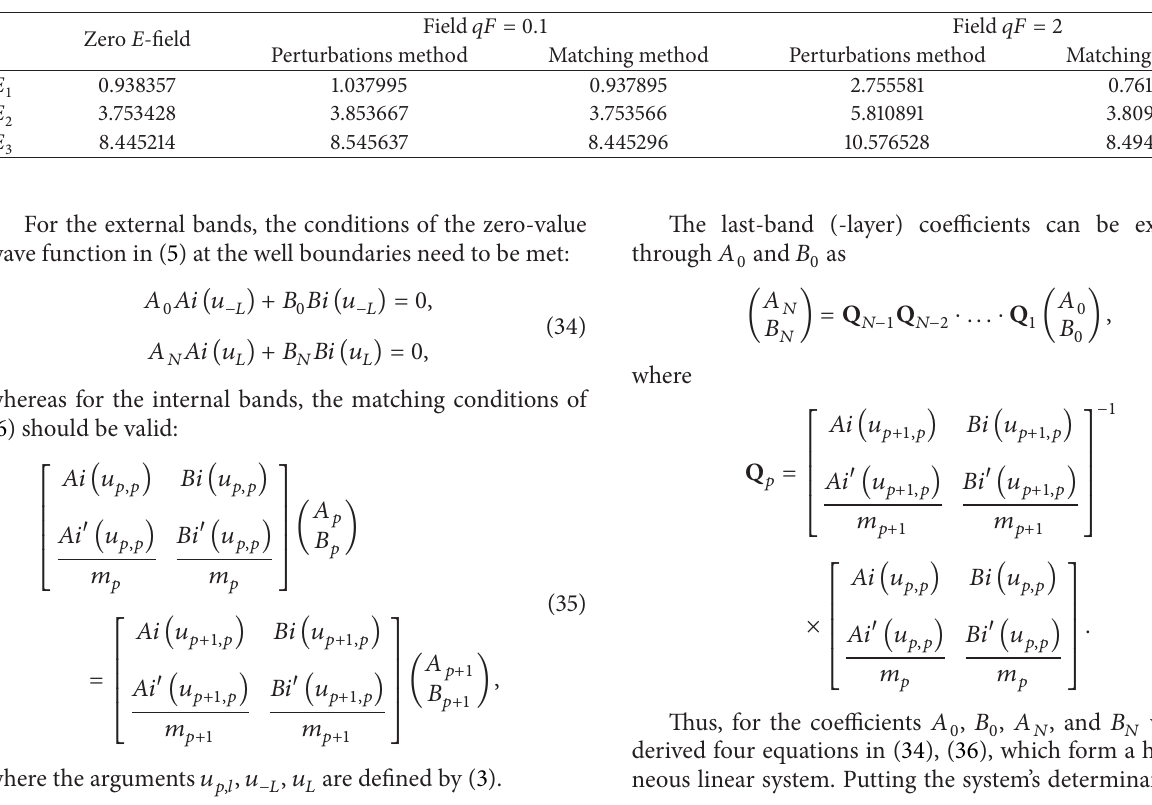
Figure 3: Wave functions for the infinite well (zero field—dashed line, 𝑞𝐹 = 0.1 —dotted line, and 𝑞𝐹 = 2 —solid line) at 𝑛 = 1 (a), 𝑛 = 2 (b), and 𝑛 = 3 (c). Table 1: Energy spectrum (first three values) for a square